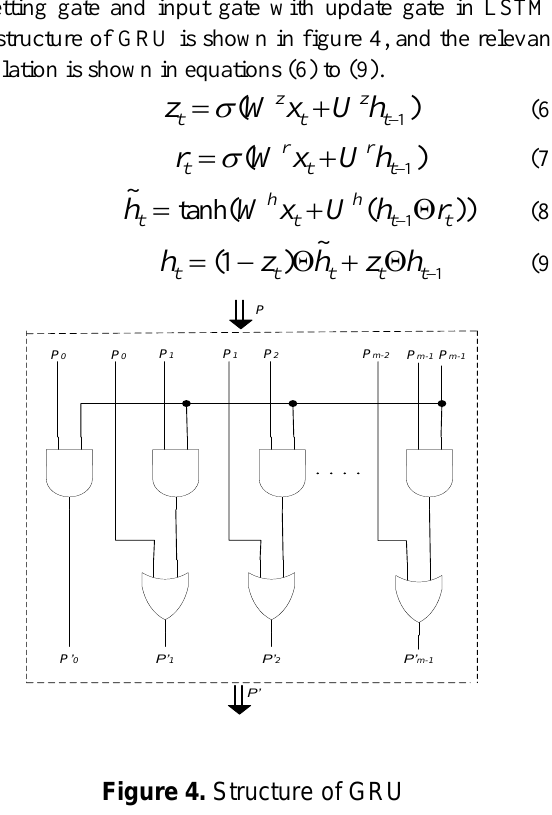
Figure 4. Structure of GRU